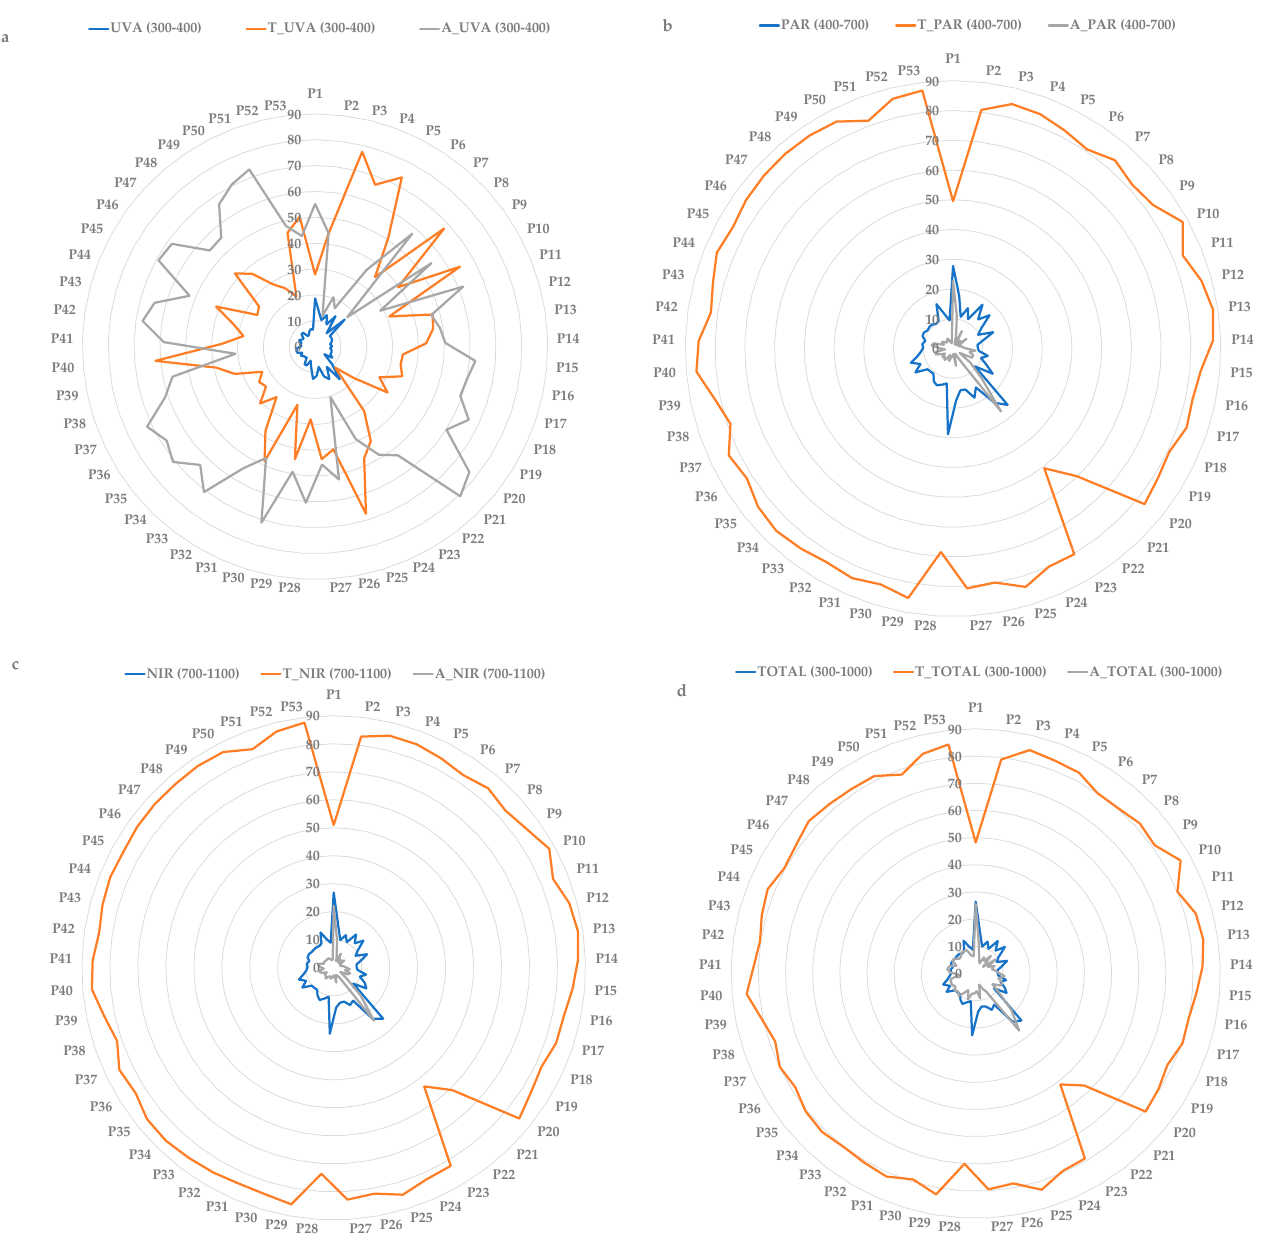
Figure 4. Radiometric behaviour of the polymeric films in the spectral region: ( a ) UVA, ( b ) PAR, ( c ) NIR, ( d ) Total spectrum.